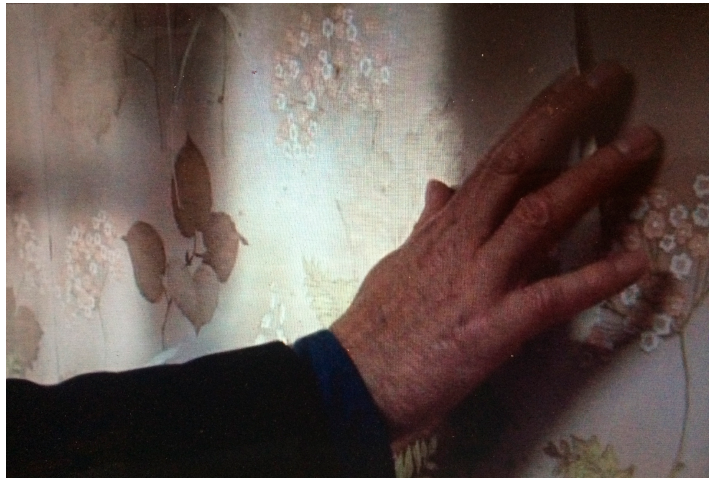
Figure 3. Peeling Wallpaper.